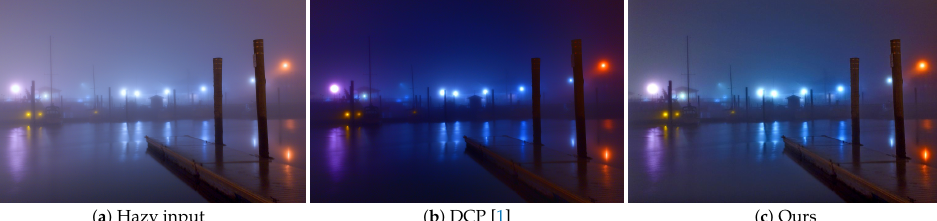
Figure 12. The dehazing result of the proposed method and state-of-the art methods on the real night hazy images. The proposed method generates much clearer images with clearer structures and characters.